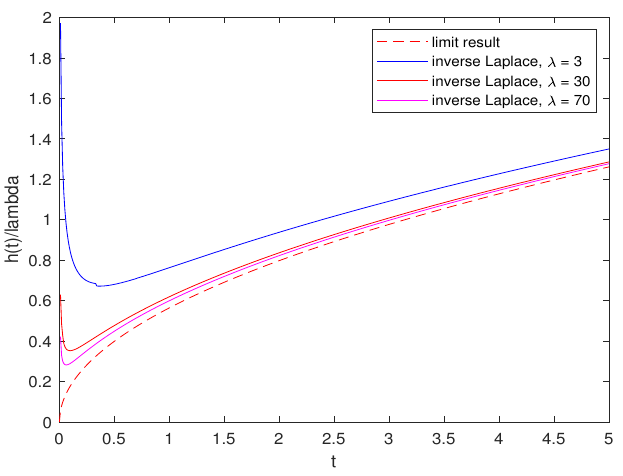
ˆ H ( 1,0 ) ( s ,0 ) √ of Equation (15) for different values of λ . λ